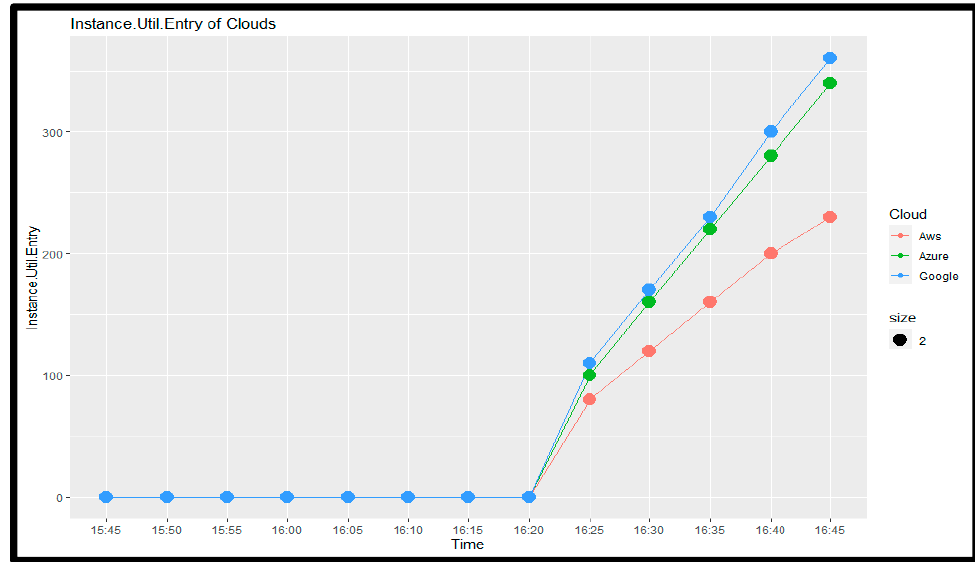
Figure 6. Instance. Utilized data Entry on clouds . Table 3. ANOVA Table for instance utilized data on clouds.